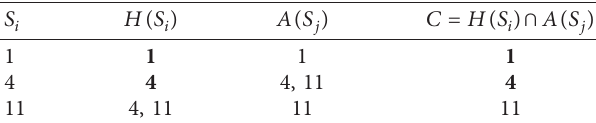
Table 3: The second-level Reachable Set and Antecedent Set in the . reduced matrix H 1